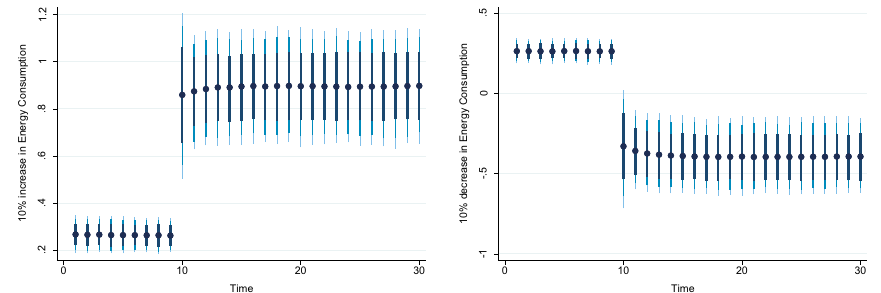
Fig. 5 The impulse response plot for energy consumption and CO 2 emissions. This figure shows a 10% increase and a decrease in energy consumption and its influence on CO 2 emissions where dots specify average prediction value. However, the dark blue to light blue line denotes 75, 90, and 95% confidence interval, respectively